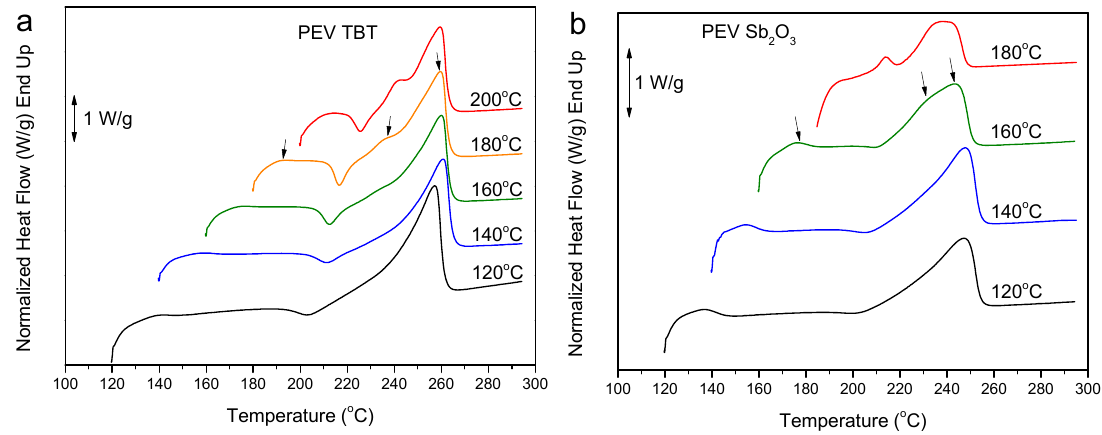
Figure 7. Subsequent DSC heating scans after isothermal melt-crystallization at the indicated temperatures for ( a ) low M w and ( b ) higher M w PEV samples.